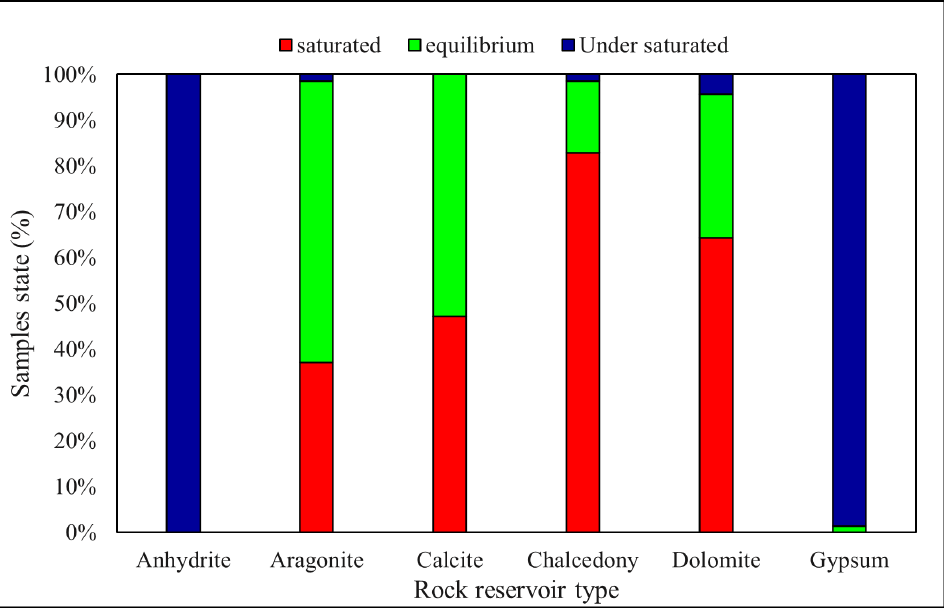
Figure 5. Variation in saturation indices of reservoir